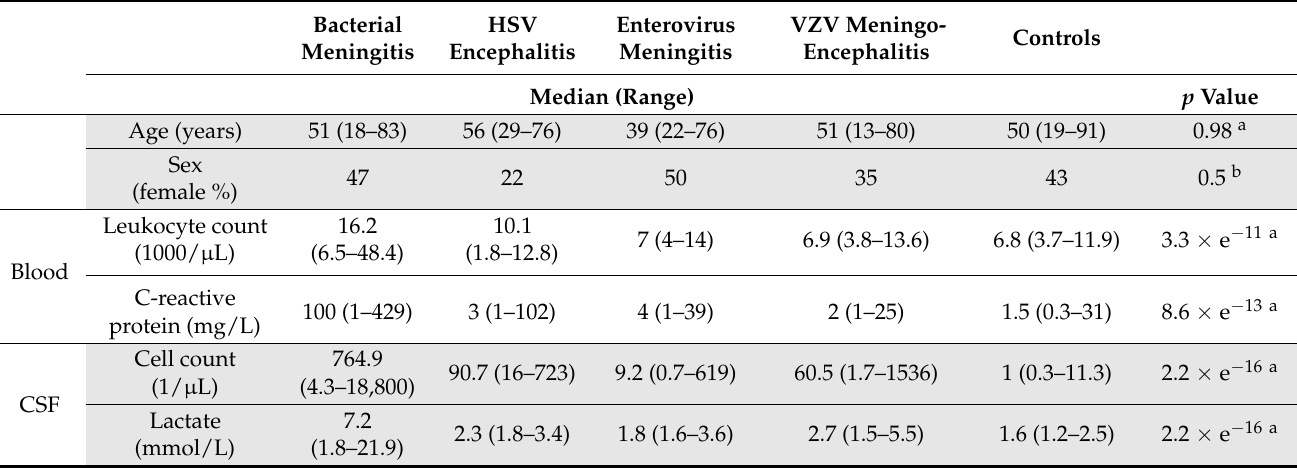
Table 1. Demographic and selected clinical laboratory